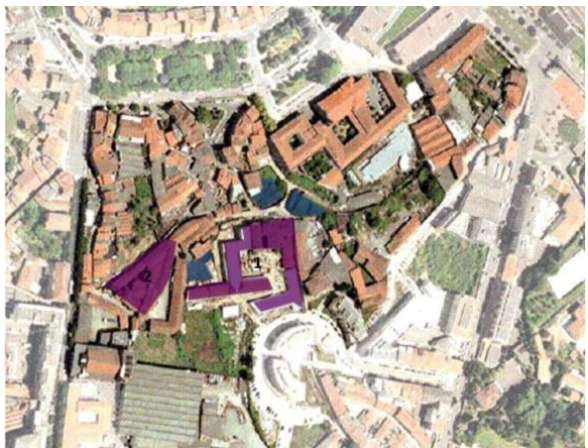
Figure 3. Aerial photograph of the Couros area, Guimarâes (Portugal). Source: drawing by the author using image from Google